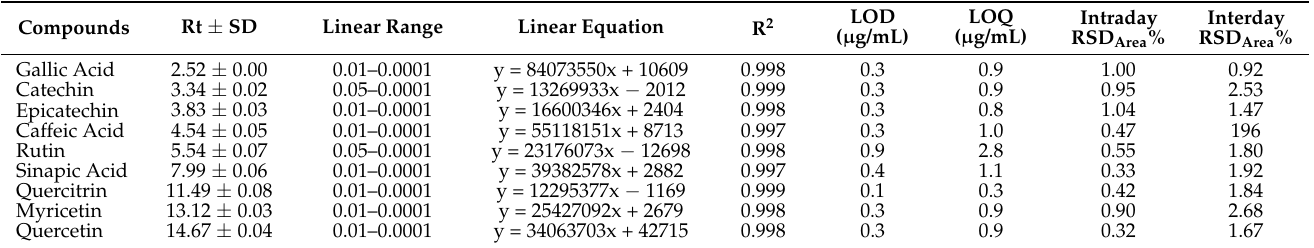
Figure 3. 3D response surface plots showing the interactive effects of process factors on TPC ( a ) and DPPH ( b ). Table 3. Limits of detection and quantification, regression equations, retention times, repeatability and reproducibility ( n =